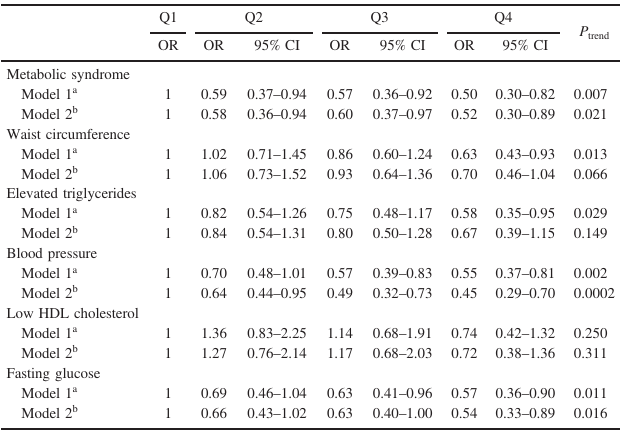
Table 4. Associations of dietary pattern 1 score with MetS and its